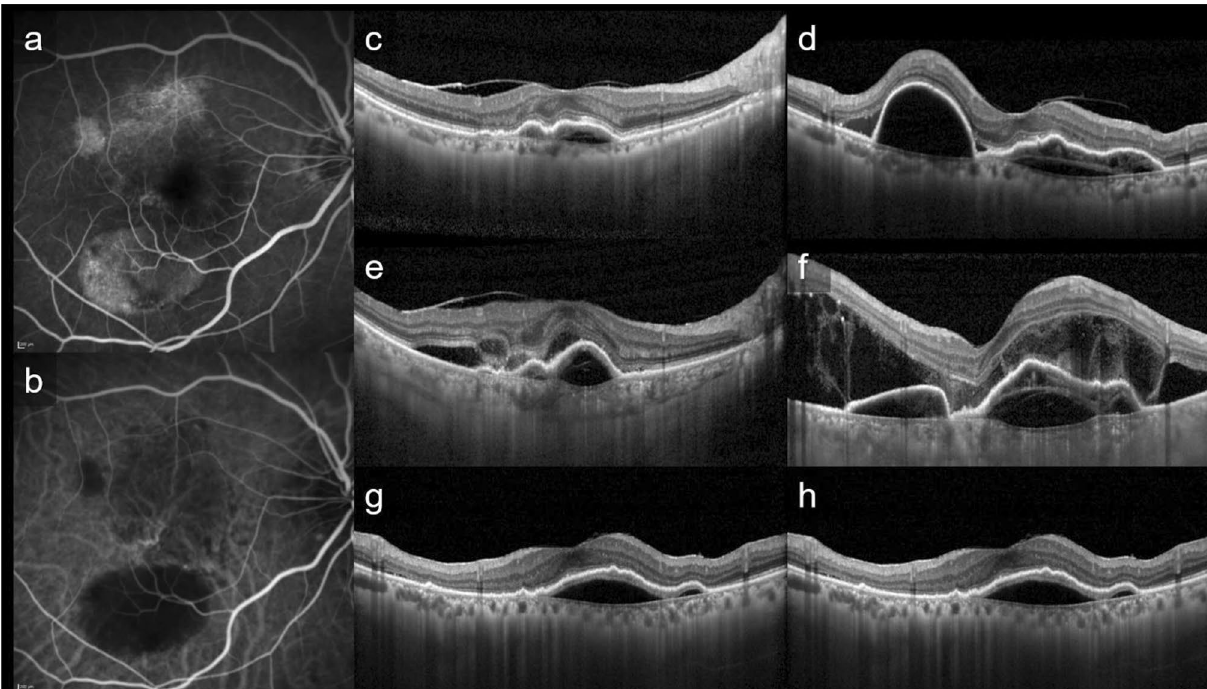
Figure 2. This is a representative case of PAEM+. Fluorescein angiography ( a ), indocyanine green angiography ( b ), and horizontal ( c , e , g ) and vertical ( d , f , h ) line of optic coherence tomography images of patients at baseline ( c , d ), 3 days follow-up ( e , f ) and 1 month follow-up ( g , h ) after photodynamic therapy (PDT). 82-year- old-female with polypoidal choroidal vasculopathy in the light eye. Central retinal thickness was 361 µm at